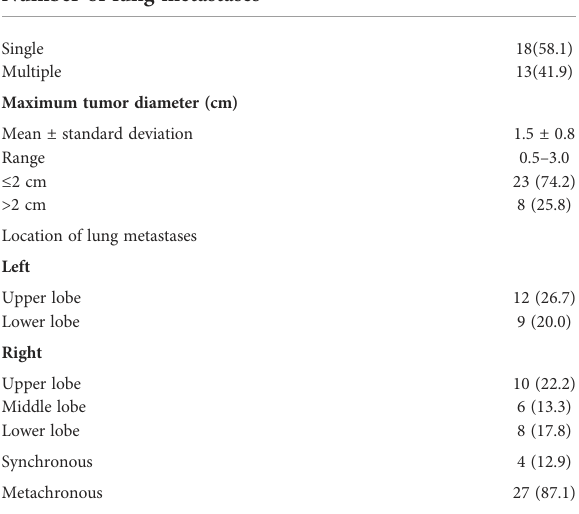
TABLE 2 Characteristics of lung metastases.